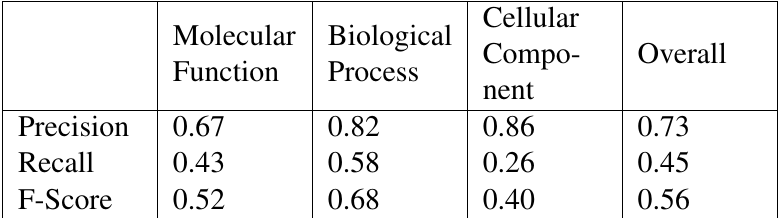
Table 1: Evaluation of annotation quality for di ff erent Gene Ontology